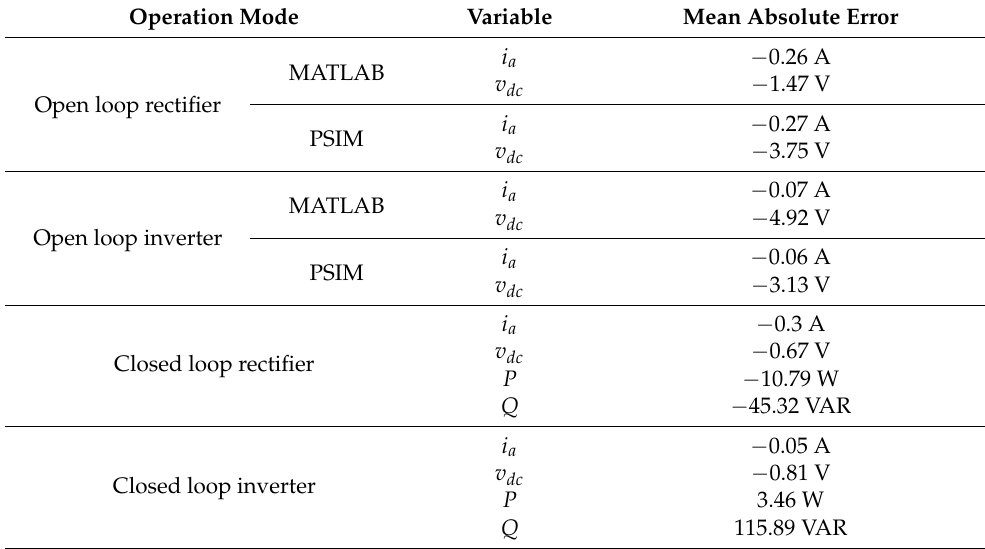
Table 2. Mean absolute